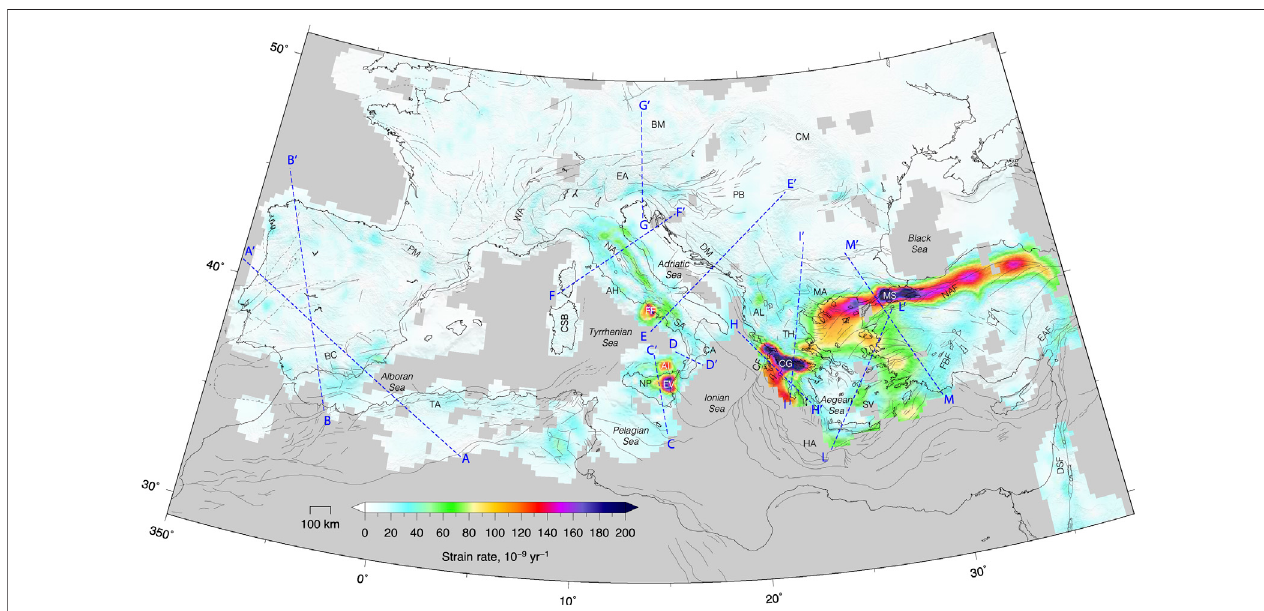
FIGURE 9 | Map of the scalar value of the strain-rate tensor de fi ned as the square root of the sum of squares of all its components (Bos et al., 2003; Tape et al., 2009). As in Figure 8 , we mask regions of the estimated vertical velocity fi eld based on the diagonal terms of the posterior data covariance. The regions shown in color are resolved to a minimum scale of ~55 km (q = 7). The dashed lines show the traces of the (~200 km wide) cross sections shown in Figures from 11 to 15. EV, Etna Volcano; AI, AEolian Islands; FF,FlegreiField; AH, Alban Hills; SV,SantoriniVolcano. BC, BeticCordillera; AS,Alboran Sea;TA, Tell Atlas; PM, Pyrenee mountains; WA, Western Alps; EA, Eastern Alps; NA, Northern Apennines; SA, Southern Apennines; CA, Calabrian Arc; NP, Nebrodi-Peloritani mountains; BM, Bohemian Massif; PB, Pannonian Basin; CM, Carpathian Mountains; DM, Dinaric mountains; AL, Albanides; HA, Hellenic Arc; CG, Corinth Gulf; TH, Thessaly; MA, Macedonia; MS,